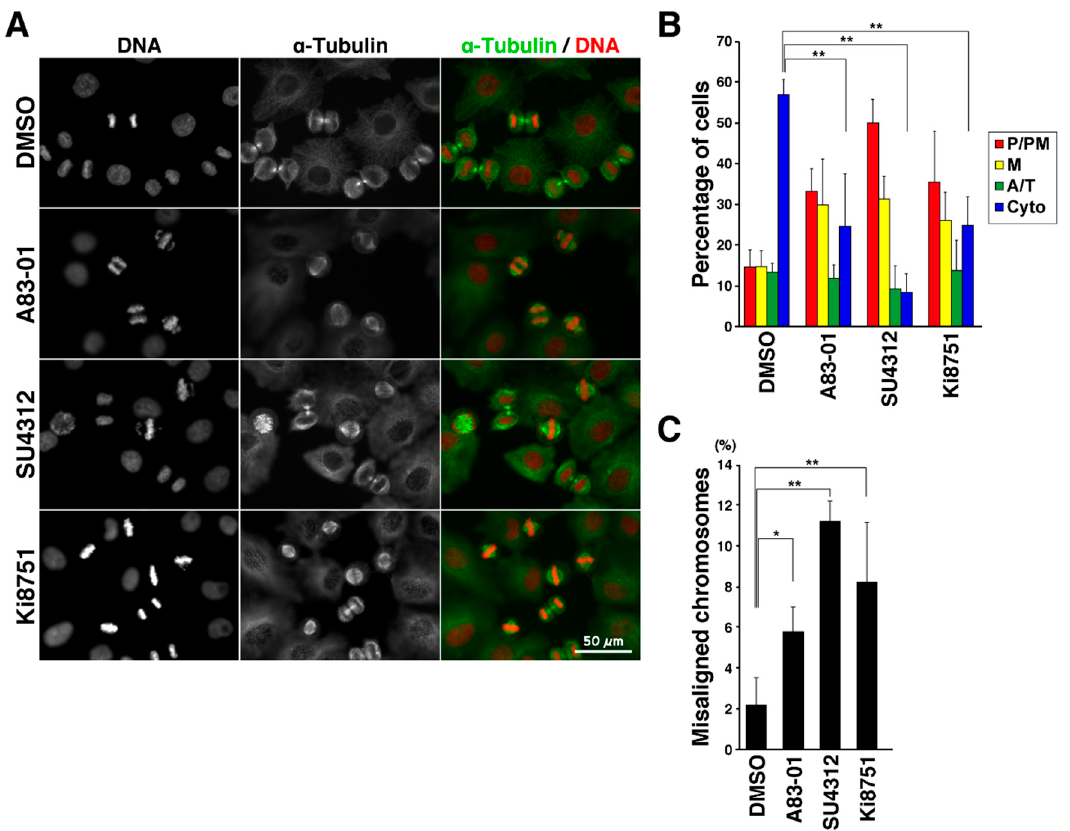
Figure 3. VEGFR inhibitors delay M phase progression. Cells were treated with 6 µM RO-3306 for 20 h. After release from RO-3306 treatment, the cells were incubated with inhibitors for 60 min and fixed with 4% formaldehyde. The fixed cells were then stained for α -tubulin and DNA. ( A ) Representative images are shown. Scale bar, 50 µm. ( B ) On the basis of α -tubulin and DNA morphologies under a microscope, the M phase cells were classified into four groups: prophase/prometaphase (P/PM), metaphase (M), anaphase/telophase (A/T), and cytokinesis (Cyto). The percentages of cells of each group are plotted as the mean ± S.D., calculated from three independent experiments ( n > 241 in each experiment). ( C ) The number of cells with misaligned chromosomes was counted under a microscope. The percentages of cells exhibiting misaligned chromosomes are plotted as the mean ± S.D. of three independent experiments ( n > 241 in each experiment). The Tukey–Kramer multiple comparisons test was used to calculate p values. * p < 0.05; ** p < 0.01; NS, not significant.